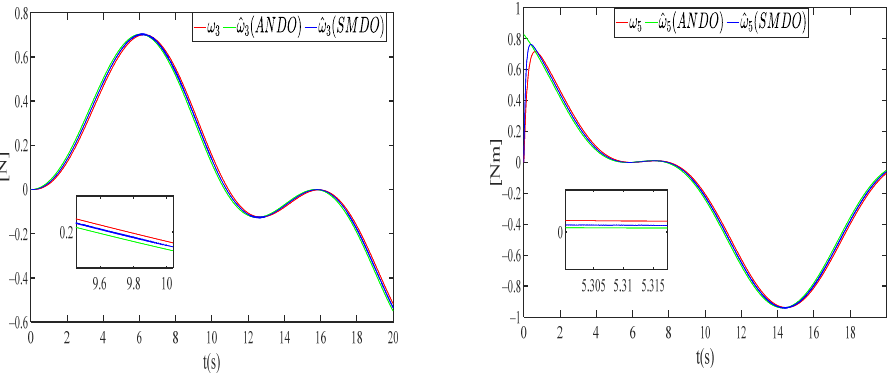
ω and ω . Figure 6. The disturbance estimation comparation in ω 3 and ω 5 3 5